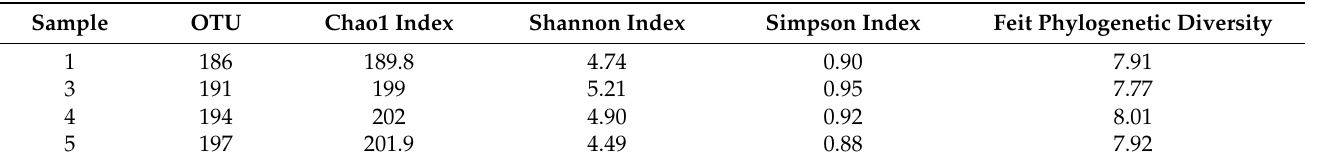
Table 2. Alpha-diversity